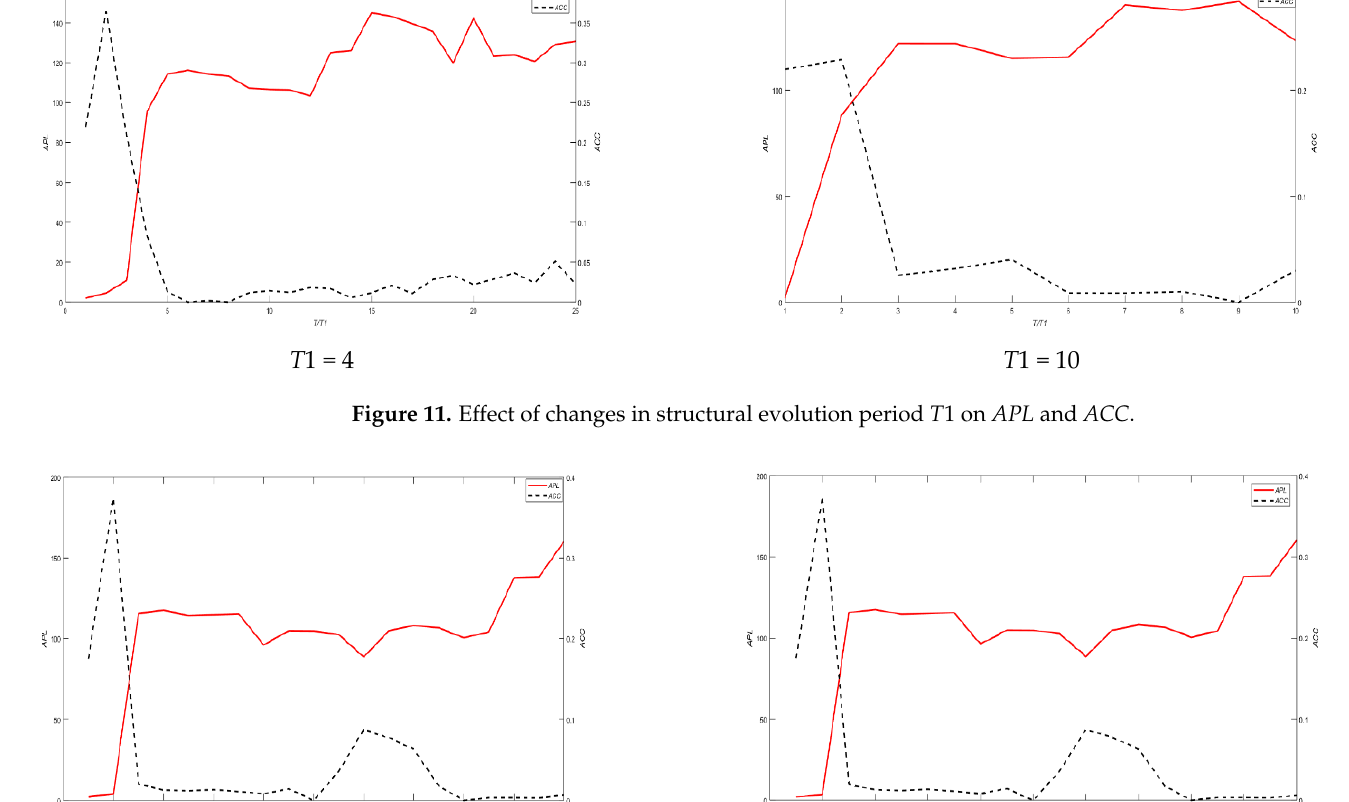
Figure 10. Effect of changes in group initial knowledge richness q on APL and ACC.